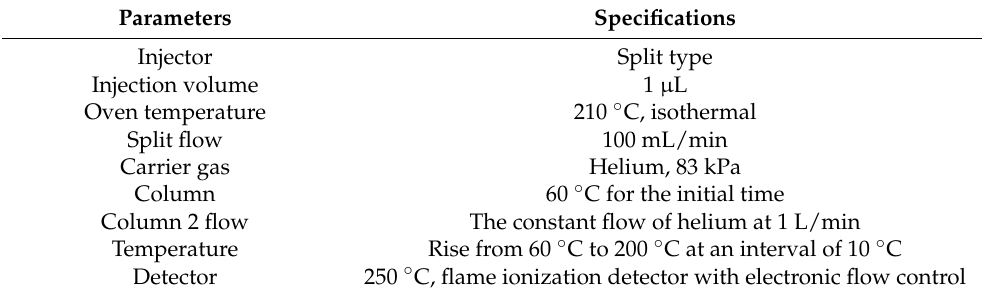
Table 1. Operating parameters of gas chromatography.